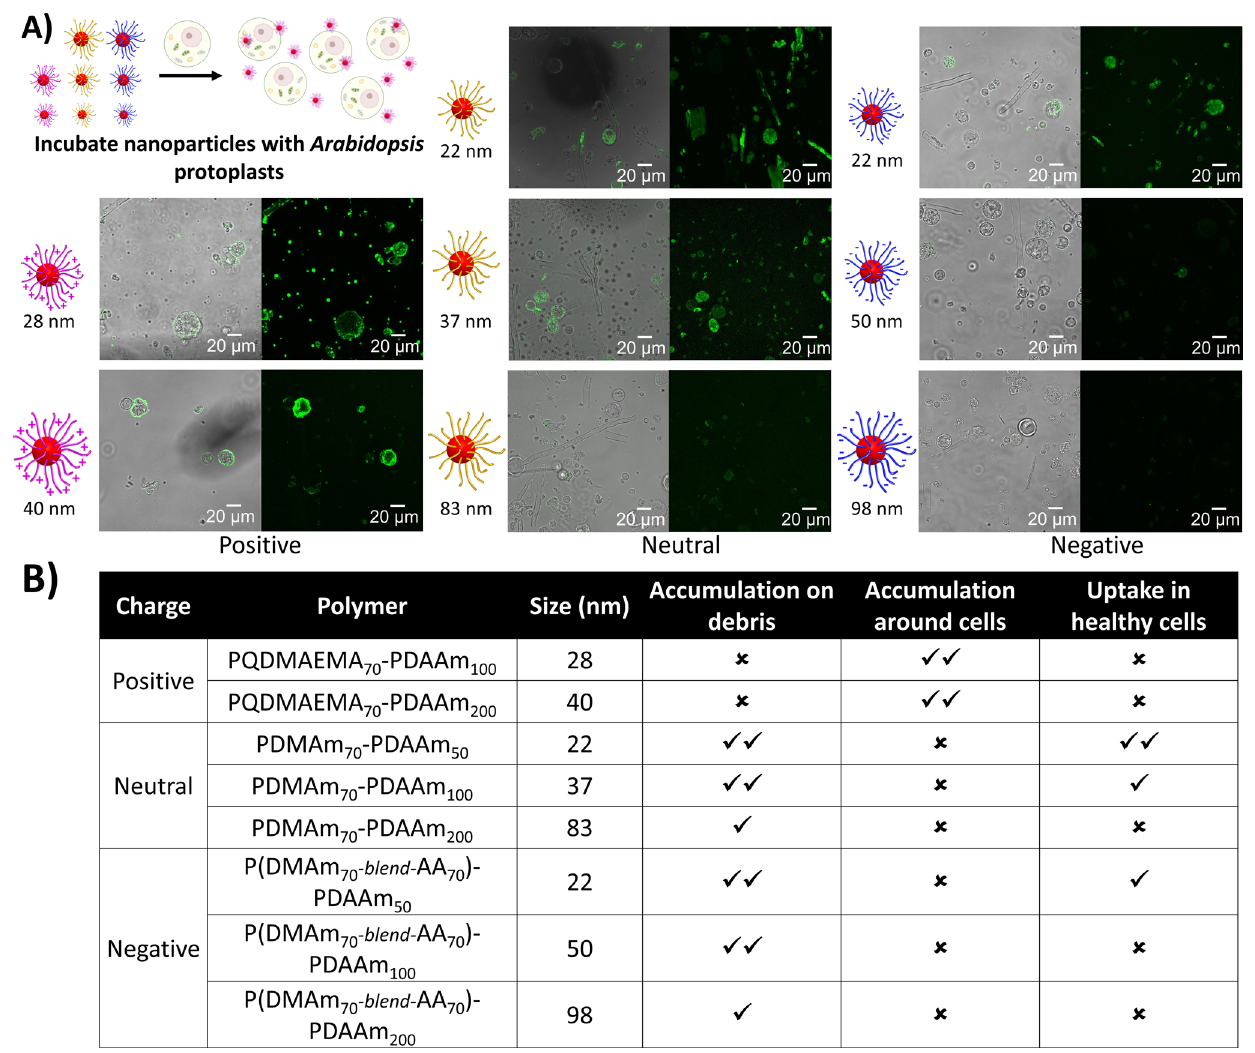
Fig. 4 | Certain nanoparticles penetrate into root cell protoplasts. a Confocal images for the penetration and distribution of polymeric nanoparticles with Ara- bidopsis protoplasts. b Summary table of the different levels of penetration observed. Good ( ✓✓ ), poor ( ✓ ), or none ( ✗ ). Penetration and accumulation were evaluated using a ZEISS 880 LSM. Maximum Z projections in the 488nm laser channel were analysed alongside the Z-slices and merged with bright fi eld images